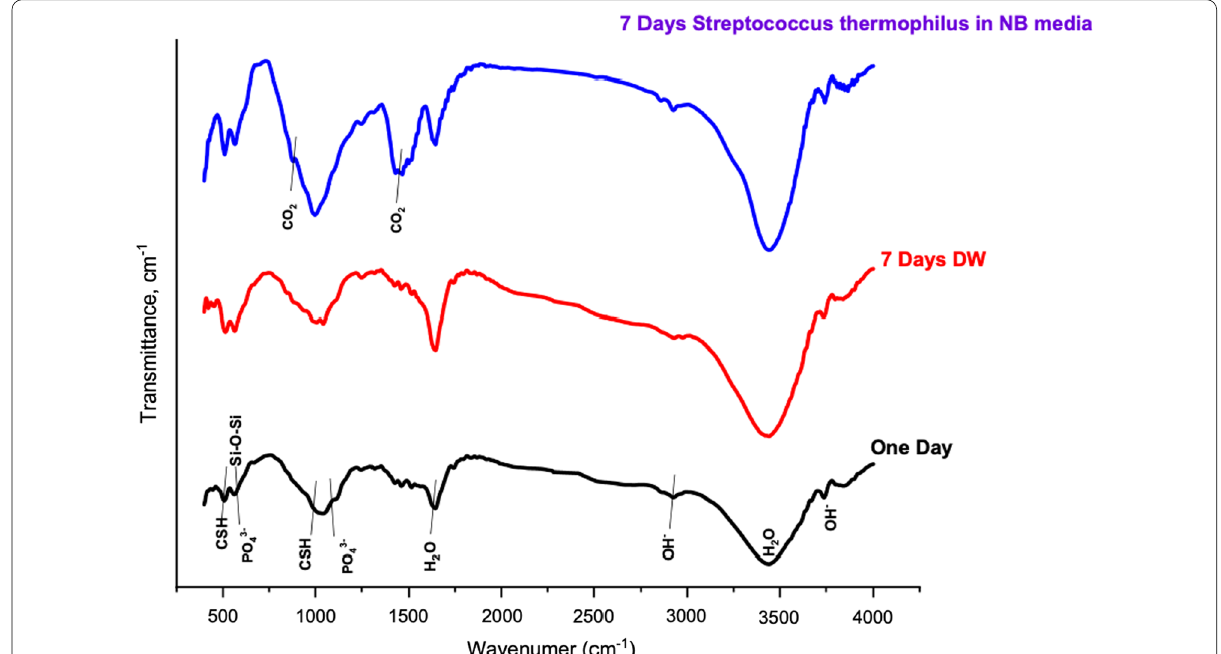
Fig. 9 FTIR spectral bands of 1-day and 7-day sample cured in distilled water (DW) and Streptococcus thermophilus bacteria in nutrient broth NB media